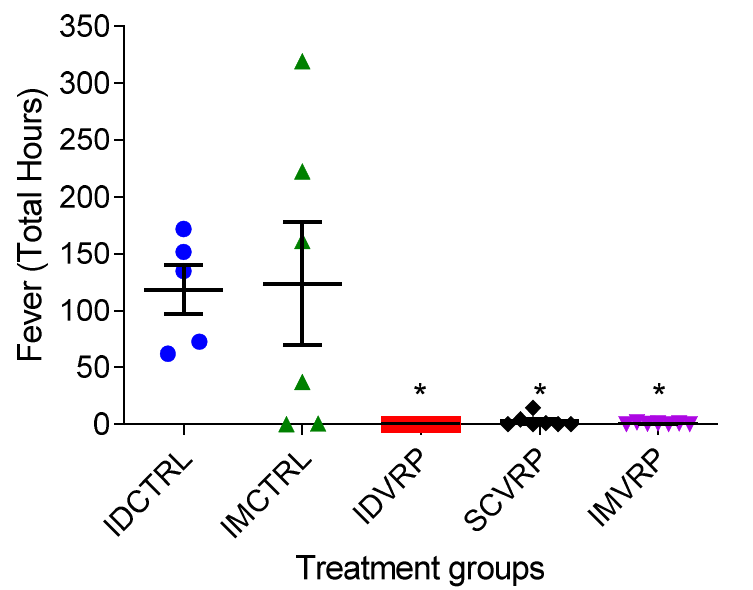
Figure 6. Total Fever Hours after aerosol exposure to WEEV CBA87. Any High temperature defined as Onset of Fever, End of Fever, or between Onset of Fever and End of Fever is defined as Fever. Any temperatures measured above the upper limit of the 99.7% highest posterior density credible interval of the error distribution was labeled as High. High temperatures are not automatically assumed to indicate fever. The total fever hours are the total time (in hours) associated with data that occur after exposure and are defined as Fever. Each symbol represents an individual NHP. The median difference in hours of fever per group (Median Fever Hours) was contrasted using the Wilcoxon Exact Test. ID VRP, SC VRP and IM VRP all have a lower median difference in fever hours than their associated controls with “statistically significant” test-wise p -values less than 0.05 (*).